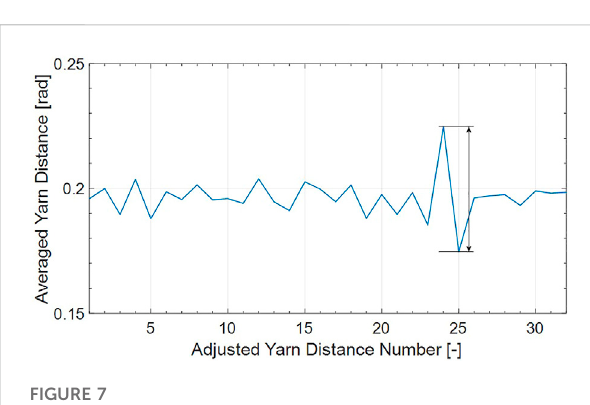
FIGURE 7 Averaged yarn distance measurements calculated from the nine diagrams shown in Figure 6 after shifting the x -axis by Formula 1 through Formula 4; prominence of defect-characteristic pattern indicated by a double